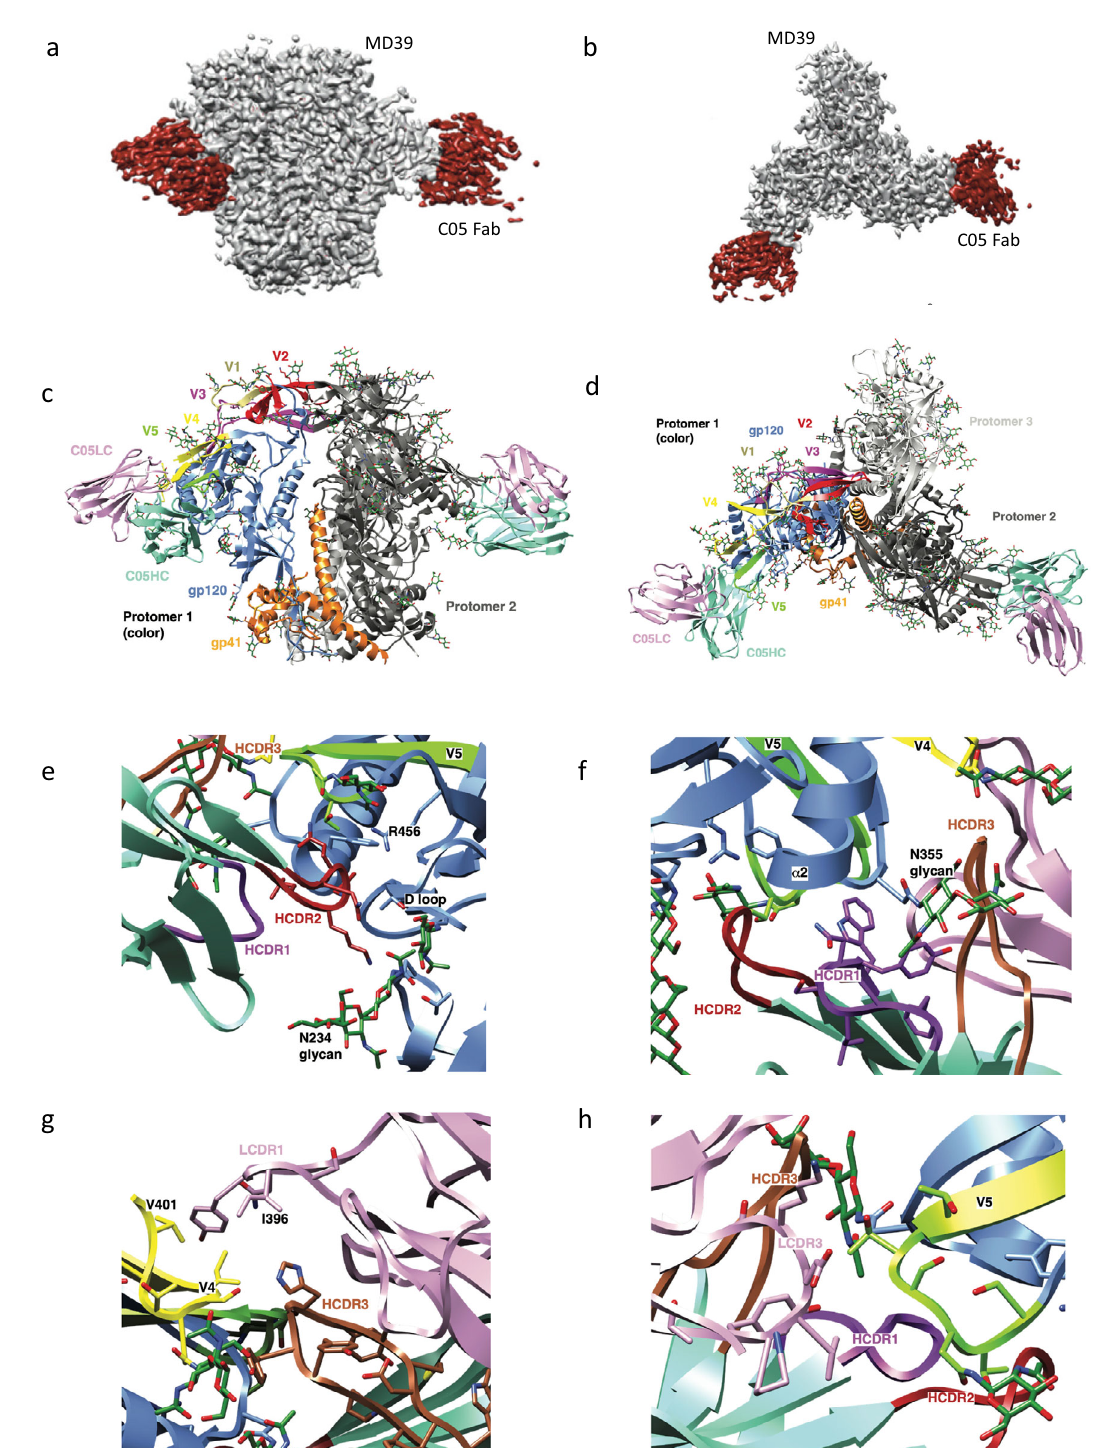
Fig. 7 Cryo-EM structure of MD39 in complex with C05 Fab. a , b Electron density map of MD39 C05 Fab complex viewed from the side ( a ) and from the top ( b ); MD39 is shown in gray; C05 Fab is shown in dark red. c Side view and d top view of the modelled structure. Env Protomer 1 is displayed in color, protomer 2 in dim gray, and protomer 3 in light gray. Env protomer 1 gp120 is displayed in corn fl ower blue, gp41 in orange, and N-linked glycans in forest green. Env variable region 1 (V1) is displayed in khaki, V2 in red, V3 in magenta, V4 in yellow and V5 in chartreuse. C05 Fab variable domains are displayed in plum (Fv light chain; C05LC) and in aquamarine (Fv heavy chain; C05HC). C05 recognizes an epitope that comprises C3 and V5, but also part of V4. e HCDR2 ( fi rebrick) engages the Env D-loop, Env N234 glycan, and R456. f HCDR1 (purple) engages the base of Env helix α 2 as well as Env N355 glycan. N355 glycan is involved in HCDR3 (sienna) engagement as well. g HCDR3 (sienna) further engages the N-terminal part of V4 (yellow). h LCDR3 (plum) recognizes V5